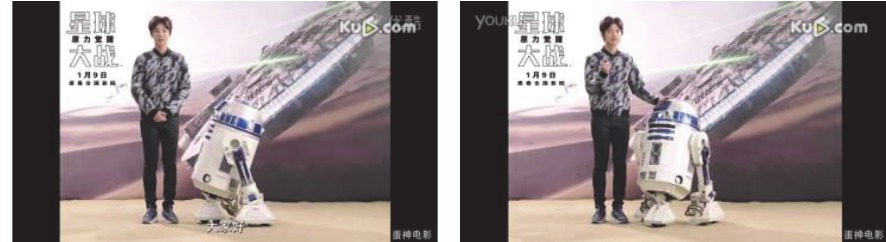
Figure 9: Optimized key frames based on the frame